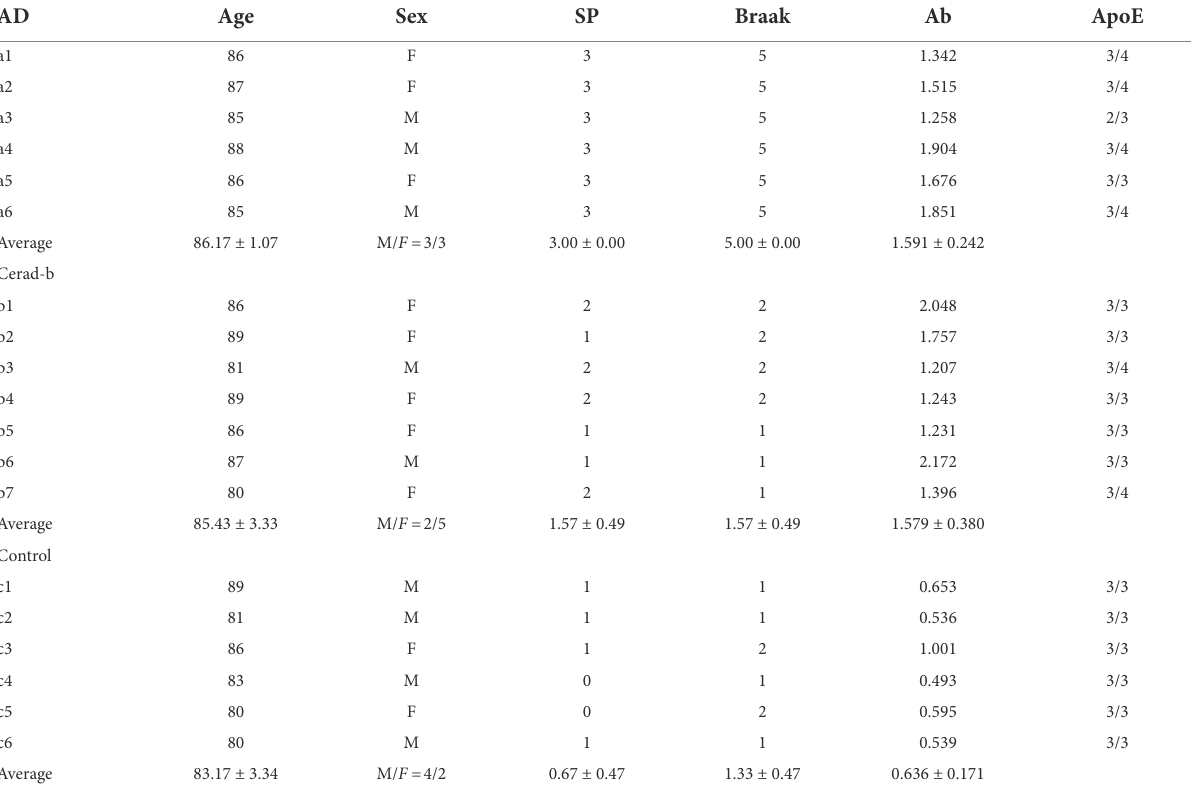
TABLE 1 Characteristics of the